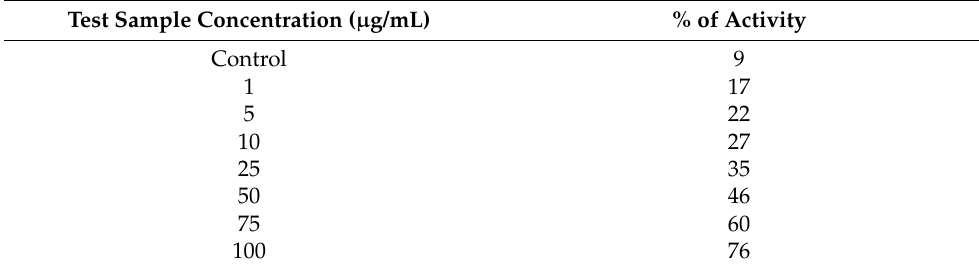
Table 1. Percentage of viability of Cu(II)-AEA NPs.